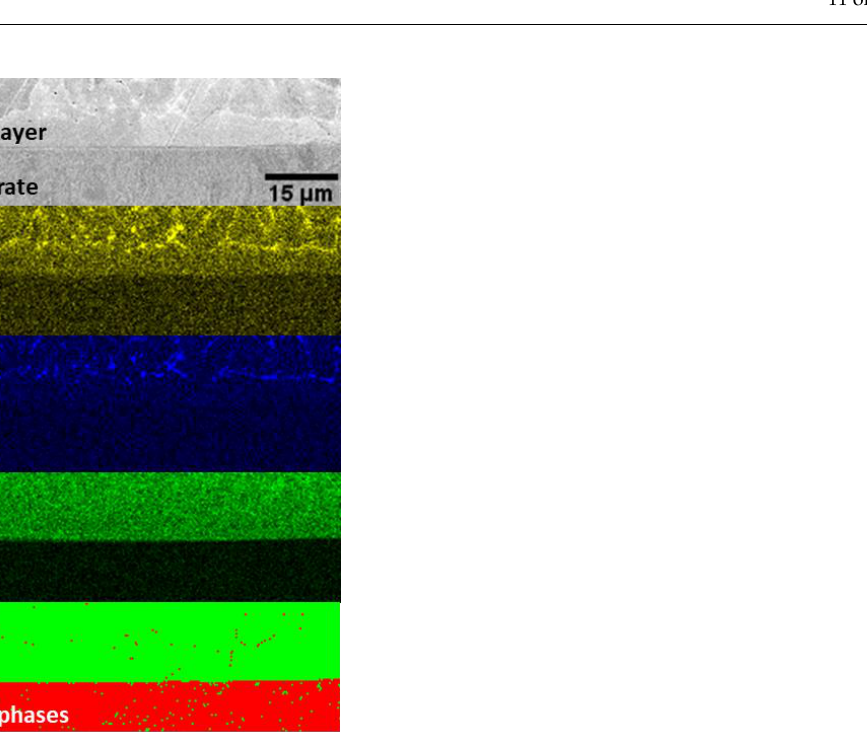
Figure 11. SEM image and elemental maps obtained by EDX microanalysis of M625 deposited on preheated (PHT) 42CrMo4 substrate. An EBSD image shows the phase distribution in this region: FCC phases in green and BCC phases in red. Figure 12 also shows that no preferential crystalline orientation was formed in the HAZ of claddings without or with PHT.